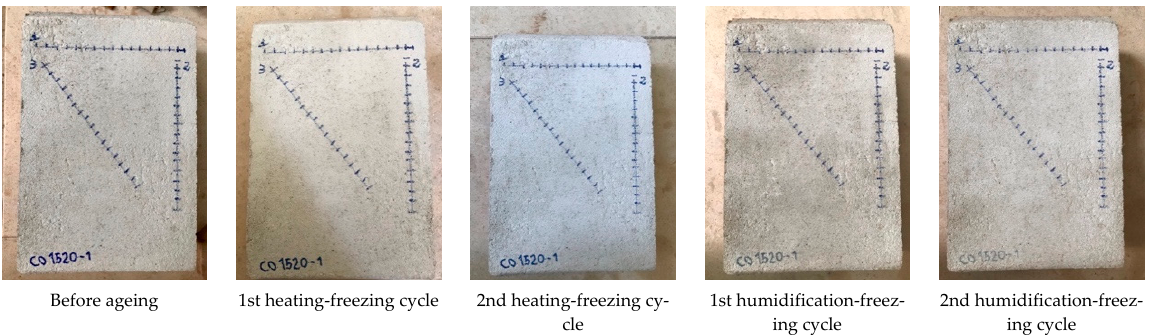
Figure 16. Visual aspect of the coir fibre-reinforced cement-lime mortar during the artificial ageing test.